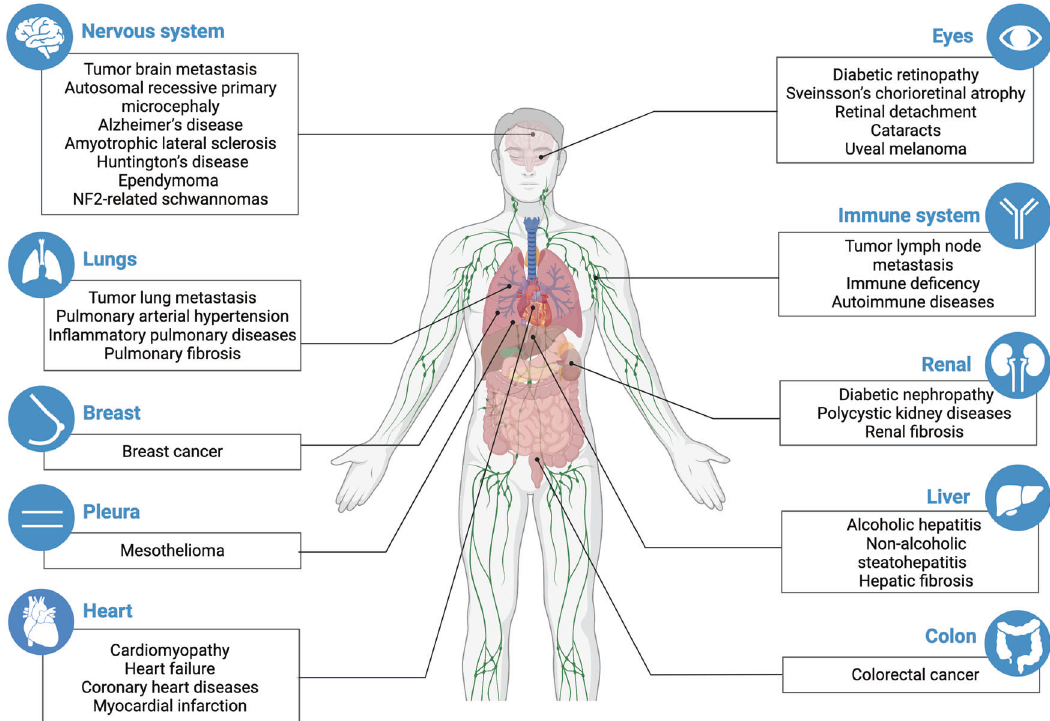
Fig. 5 The summary of diseases caused by the dysregulation of the Hippo pathway. Hippo pathway dysregulation has been found to be present in a variety of organs or systems diseases and involved in the regulation of occurrence or progression of these diseases. The speci fi c diseases are shown in